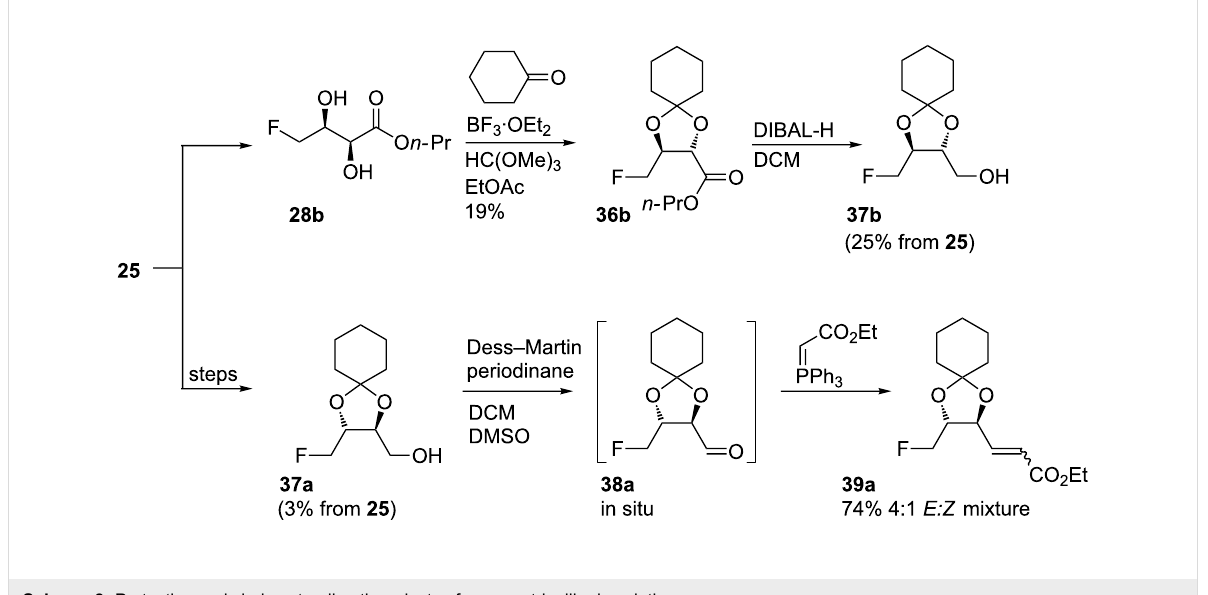
Scheme 8: Protecting and chain extending the educts of asymmetric